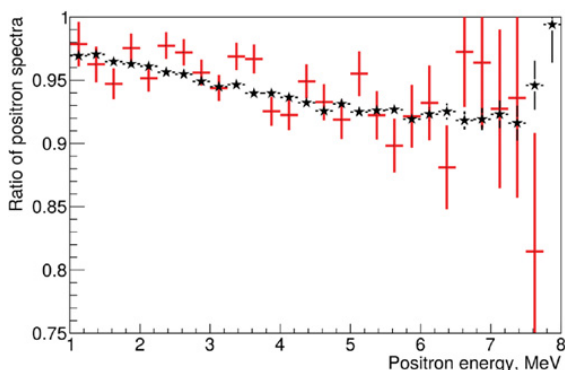
Figure 8. Ratio of positron energy spectra collected during the last 3 months of the reactor campaign in 2017 and during the 2nd–4th months from the beginning of the next campaign (statistical errors only). The average 239 Pu fission fractions for these periods are 37.7% and 27.1% correspondingly. Stars are the Hueber-Mueller model MC